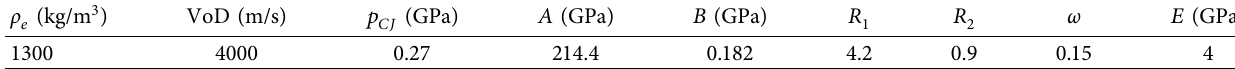
Table 4: Parameters of emulsion explosive and JWL equation of state.